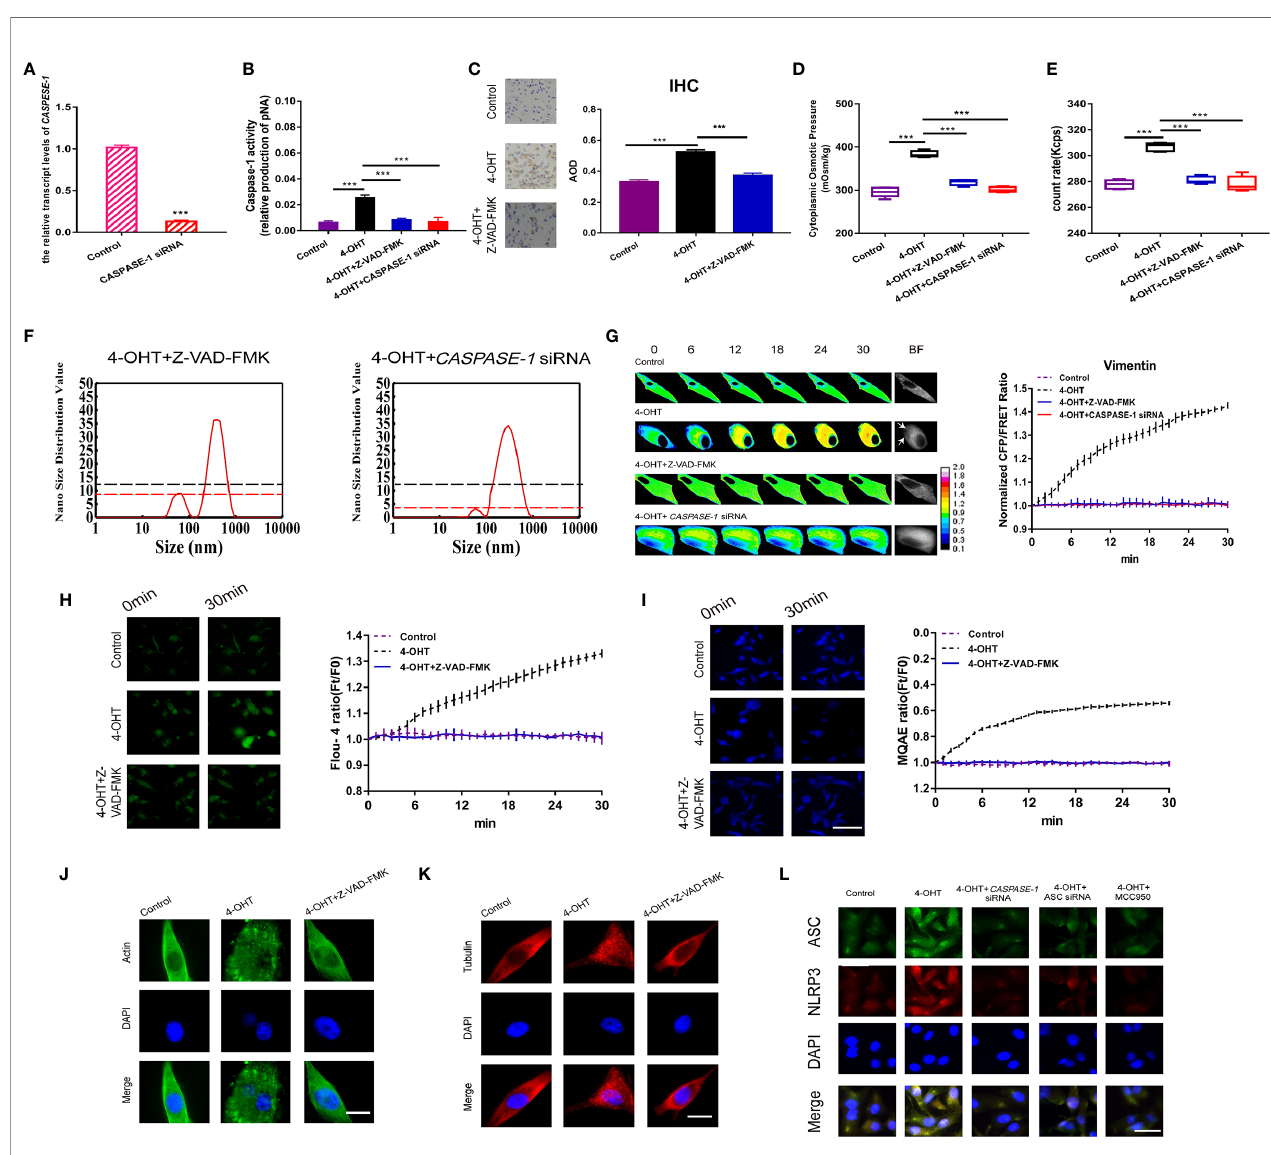
FIGURE 4 | Caspase-1 inhibitor decreased PN-OP and prevented pyroptosis. (A) RT-qPCR was used to measure the relative transcript level of CASPASE-1 after transient transfection with the CASPASE-1 siRNA. (B) Z ‑ VAD-FMK (20 m M) treatment or CASPASE-1 siRNA transfection of U87 cells inhibited the caspase-1 activity. (C) IHC analysis of caspase-1 expression in brain section of the sepsis mouse models. The cytoplasm was stained with the caspase-1 antibody (brown). Semiquantitative analysis of the IHC staining by comparison of AOD among the groups. (D) The cytoplasmic OP values of U87 cells were measured using a freezing point osmometer. (E) The count rate of PNs in U87 cells. (F) Nano size distribution value of protein granules in the cytoplasm. Black dash line represents value of the 50-100 nm peak in the 4-OHT group. (G) Representative images and mean values of normalized CFP/FRET ratios of Vimentin tension. Arrows indicate the membrane blebbing regions. (H) Calcium imaging micrographs and traces of relative Fluo-4 fl uorescence intensity (Ft/F0) of cells. (I) Chloridion imaging micrographs and traces of relative MQAE fl uorescence intensity (Ft/F0) of cells. (J, K) Monolayers of U87 cells were stained for b -actin (FITC), a -tubulin (TRITC). (L) Immuno fl uorescence of ASC and NLRP3 in U87 cells using antibodies. The images were generated from the fl uorescence inverted microscope after immuno fl uorescence staining. Mean of ≥ 3 experiments ± SEM. Values marked with asterisks are signi fi cantly different, as determined using a t